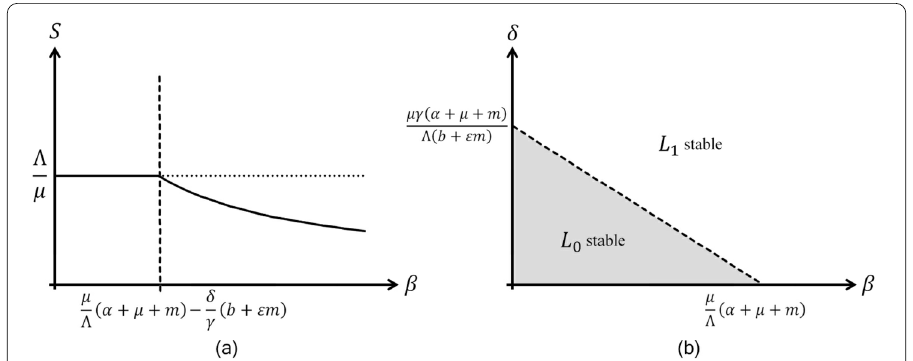
Figure 4 Bifurcation diagram of unforced SISP model. ( a ) The bifurcation diagram of susceptible host with bifurcation parameter β . ( b ) The two-parameter bifurcation diagram for β and δ illustrating the stability